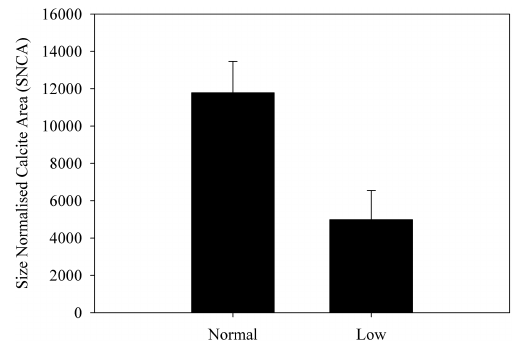
Figure 9. Size-normalised calcite area (SNCA). Normal=pH n - shells, low=pH low -shells.